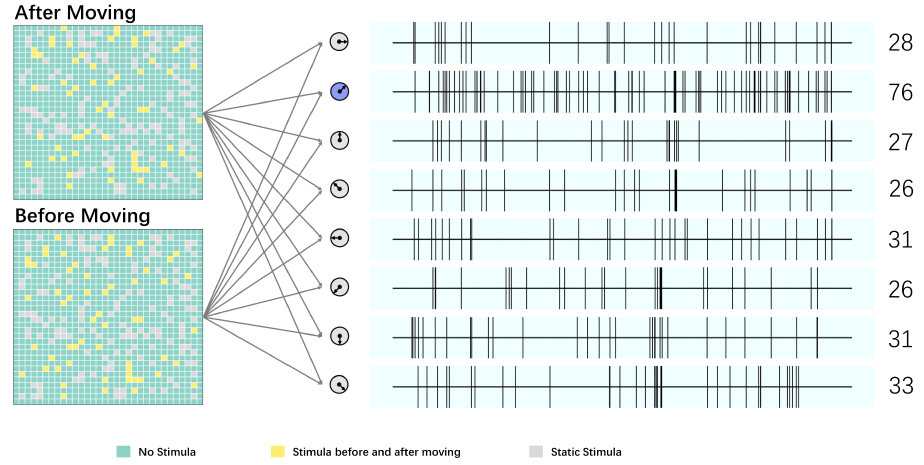
Figure 7. Computer simulation of machanism for detecting the moving direction of a random-dot pattern in two dimensions; 30% patterns were selected randomly and were displaced. (LEFT) images before and after moving, (RIGHT) responses of neurons recorded.